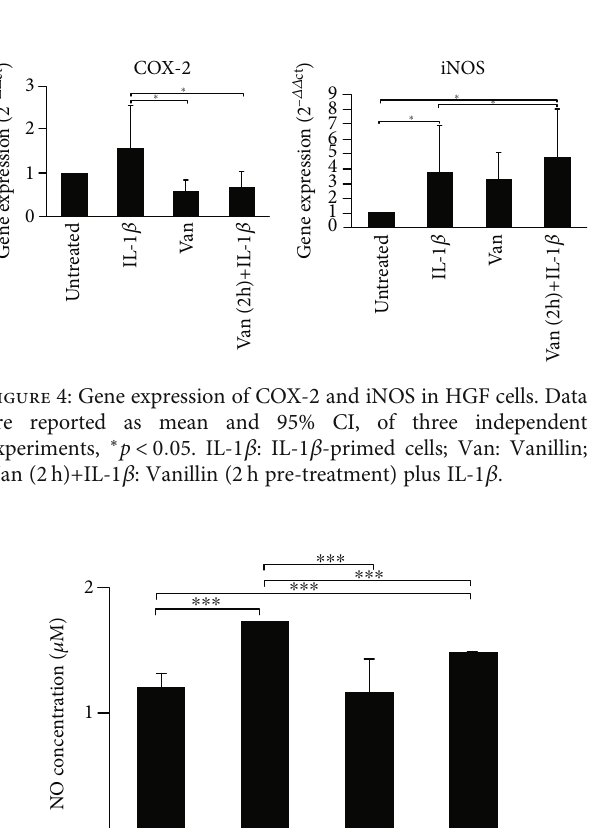
Figure 3: Gene expression of TNF- α , IL-6, IL-8, and nAChR α 7 in HGF cells. Data are reported as mean and 95% CI, of three independent experiments. ∗ p < 0 : 05 . IL-1 β : IL-1 β -primed cells; Van: Vanillin; Van (2 h)+IL-1 β : Vanillin (2 h pretreatment) plus IL-1 β .